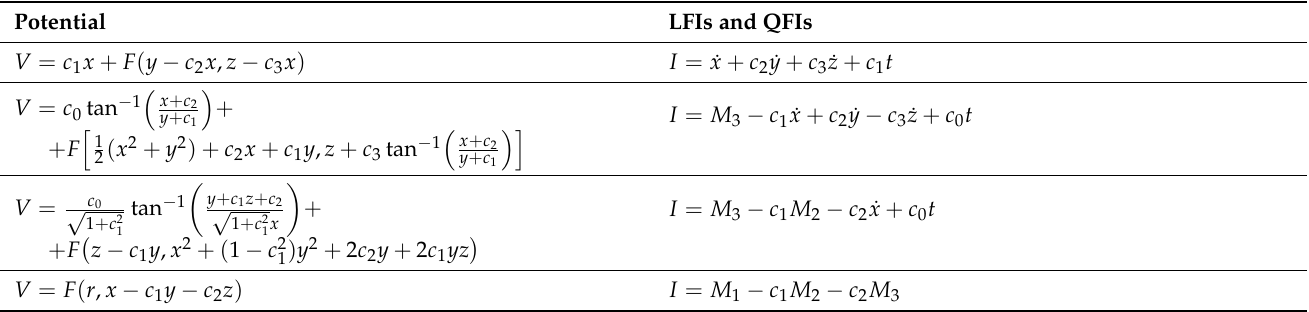
Table 10. Possibly non-integrable potentials V ( x , y , z ) in E 3 that admit LFIs of the form I = L a ˙ q a + st